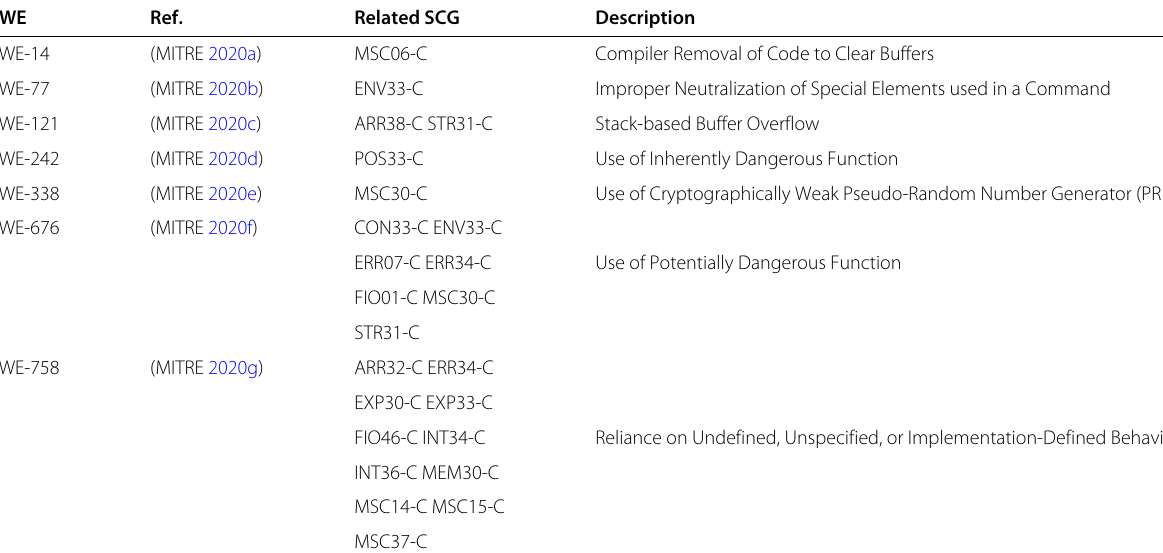
Table 3 Common weakness enumeration used in Sifu challenges CWE Ref.